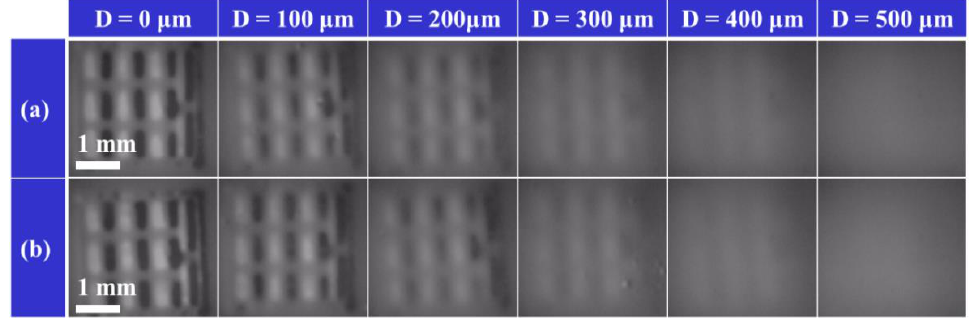
Figure 8. Change in the tag photographed image due to a change in sensing distance. ( a ) Sensing image in air. ( b ) Sensing image in water. Both are less than 300 μm, making it possible to identify tag sections with the naked eye.